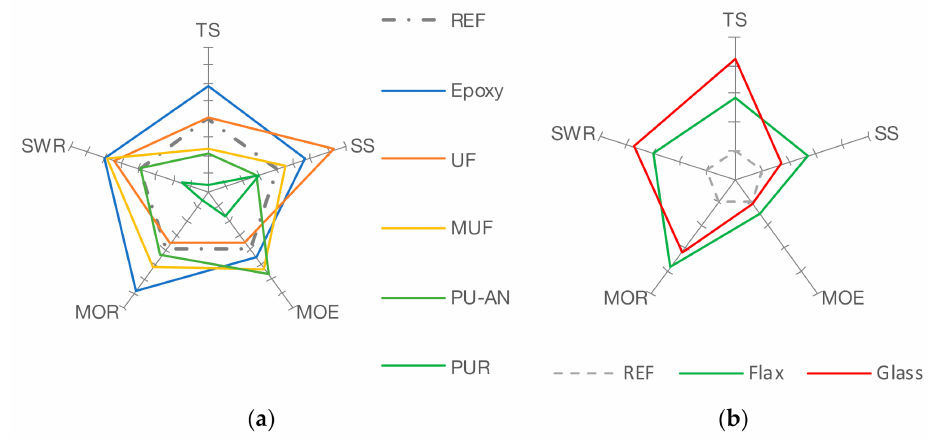
Figure 8. ( a ) Performance of flax fiber reinforcement (axis interval 5%). ( b ) Comparison of the flax and glass fiber reinforcement (axis interval